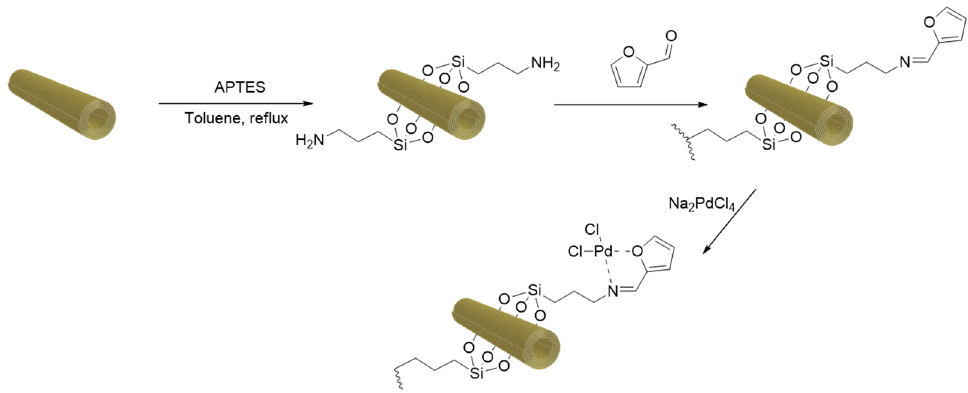
Figure 13. Synthesis of the 1st and 2nd generation HNTs triazolium salt ‐ based catalysts and their application in the Suzuki reaction.